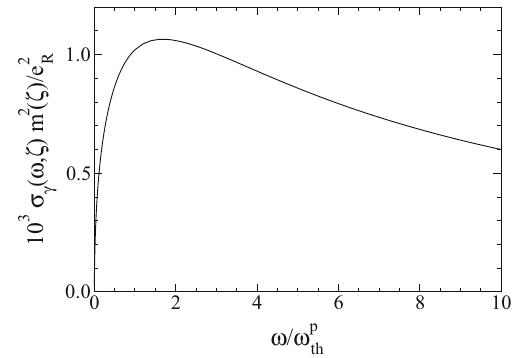
Fig. 3 The first iteration of the Källén–Lehman weight for the photon propagator, Eq. (39). N.B. in this case there is no dependence upon the IR-regulator, ζ p , as shown in Eq. (86). The threshold is given by ω p = [ 2 m (ζ) ] 2 th